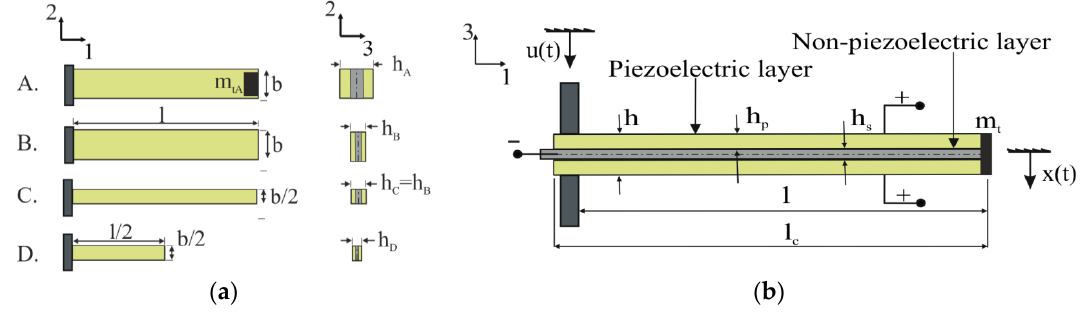
Figure 1. ( a ) The piezoelectric energy harvesters (PEHs) under investigation ( b ) Cantilevered bimorph piezoelectric energy harvester.